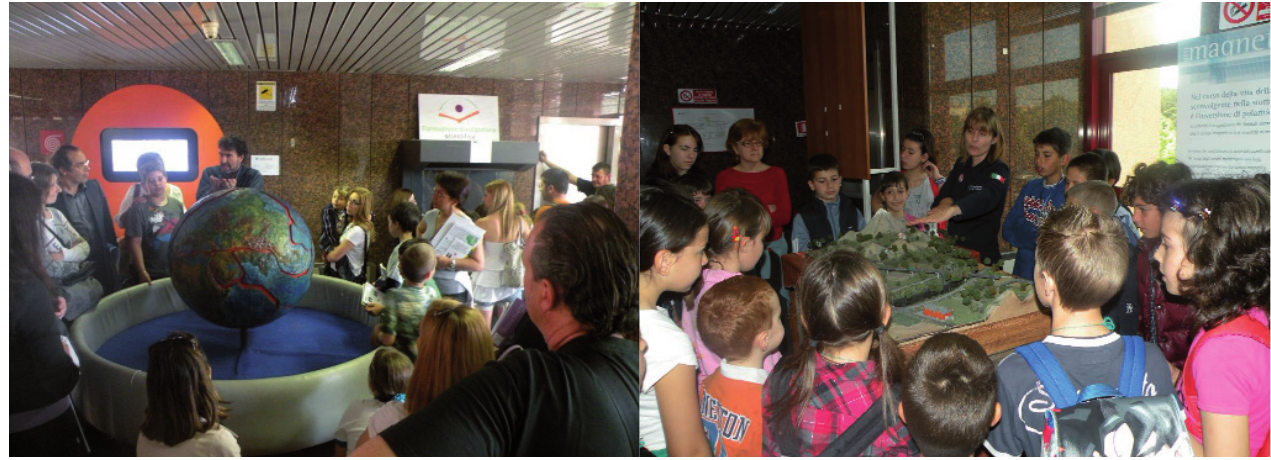
Figure 3. People visiting the earthquake and Earth interior